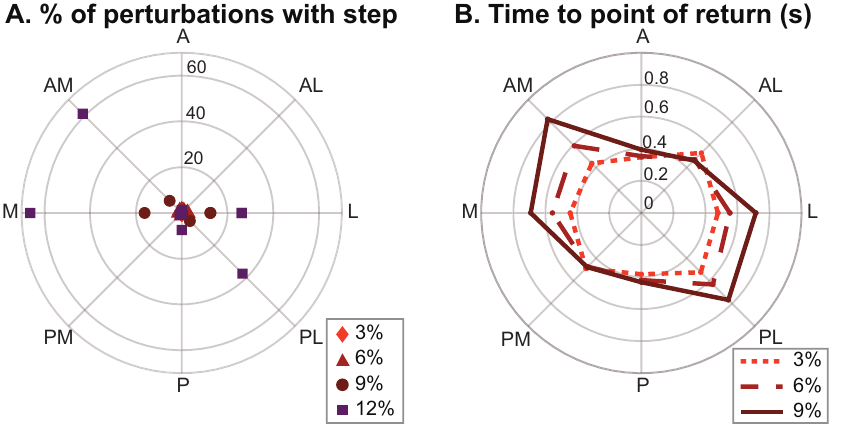
Fig 2. Effect perturbation on stepping and time to point of return. All based on group averages. A) The percentage of the perturbations in each direction and magnitude after which a step was required. B) Time needed to reach the point of return for each perturbation magnitude and